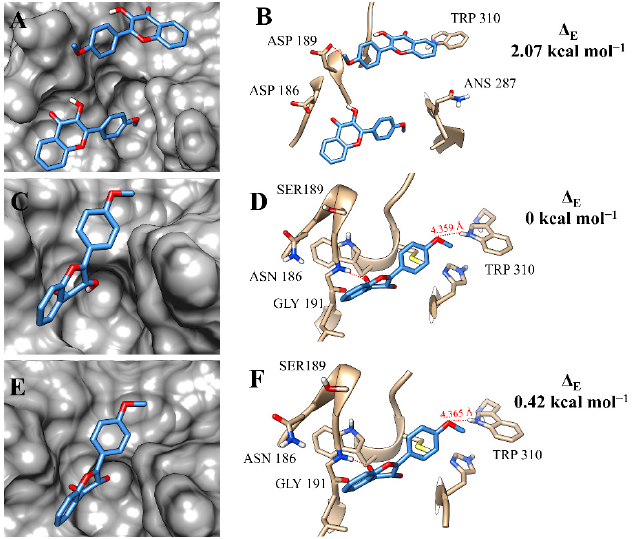
Figure 6. Binding mode positions of flavonol f12a at the active site of rCPB2.8 ( A , B ), rCPB3 ( C , D ), and rH84Y ( E , F ). The hydrogen bonds are represented by a red dashed line.